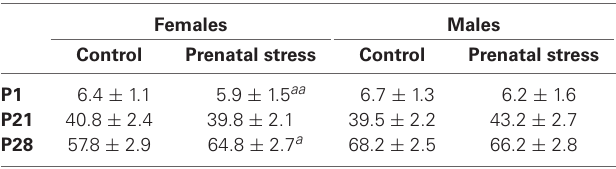
Table 1 | Animals’ body weight (g) before the beginning of pharmacol- ogical treatment: at birth (P1), at weaning (P21) and at 4 weeks of age (P28) ( n = 18–20 animals per group and sex)